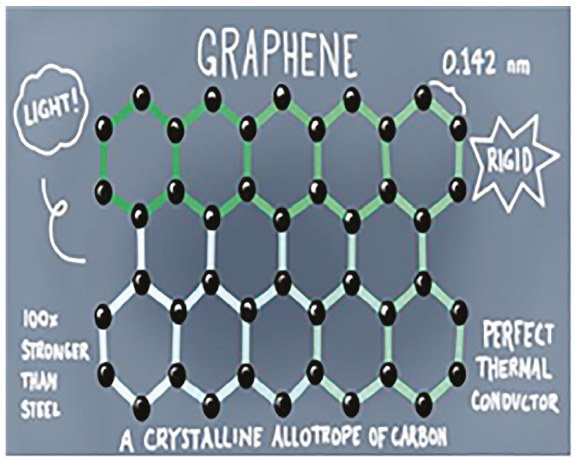
Figure 6: Graphene structure.